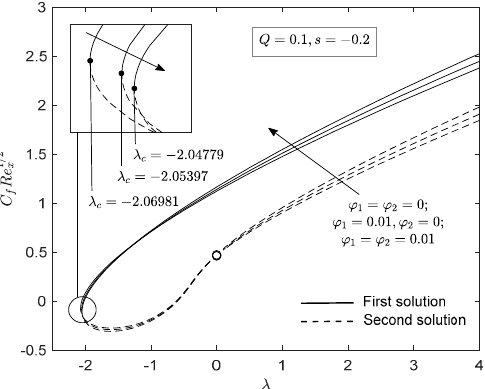
Figure 4. C f Re 1/2 x for selected value of the nanoparticle when s = 0.2.